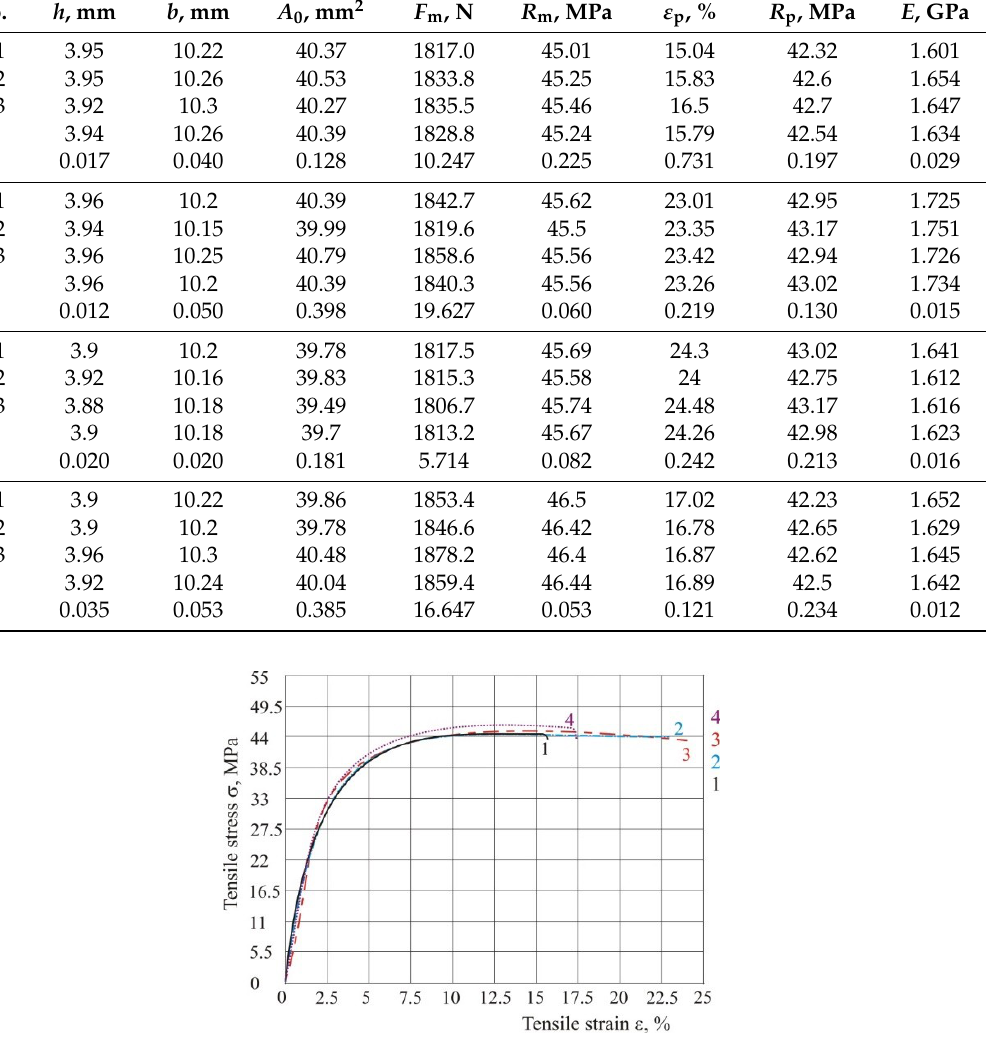
Figure 9. Tensile stress–strain curve with same energy according to Table 3.